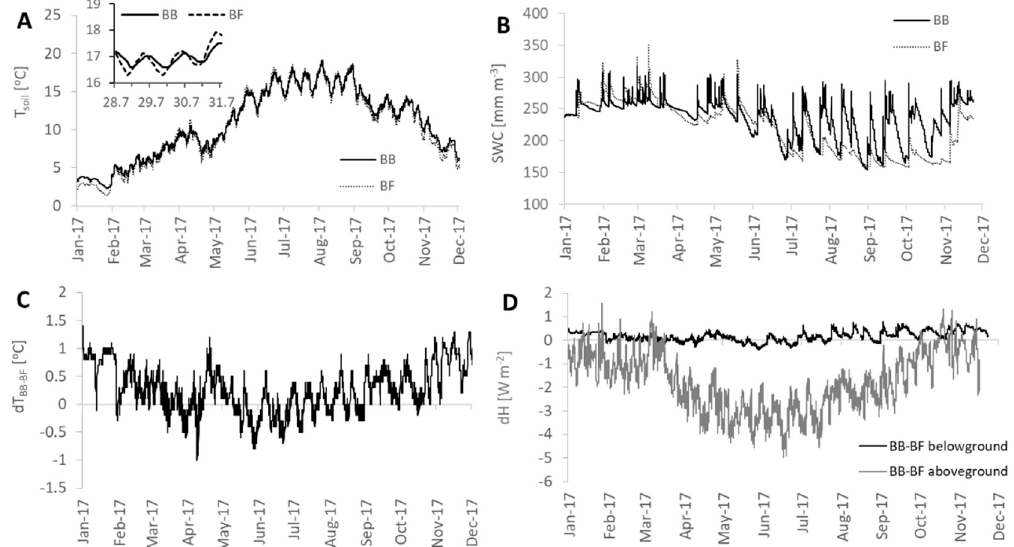
Figure 4. ( A ) Measured soil temperatures (top, left) with development at BB and BF sites over three days in July 2017 depicted in the inserted graph and ( C ) differences between sites (bottom, left). ( B ) Measured soil water content (top, right) and ( D ) energy storage differences between BB and BF sites (bottom, right).